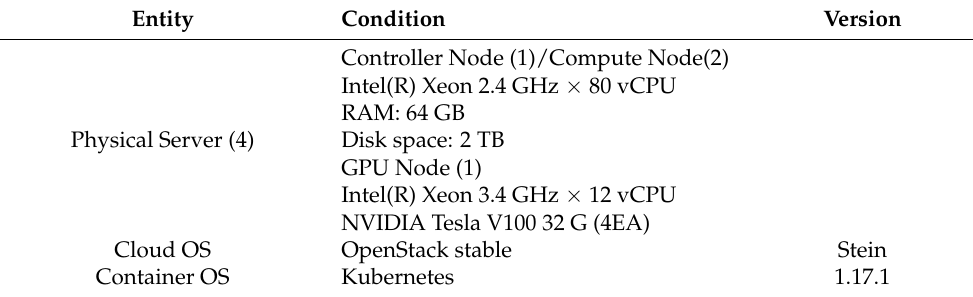
Table 2. Implementation specifications for container.